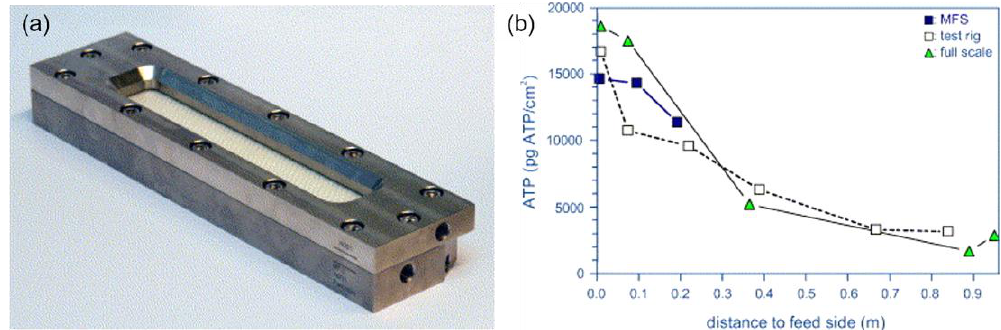
Figure 7. ( a ) A photograph of the developed membrane fouling simulator (MFS), external dimensions of 7 cm × 30 cm × 4 cm); ( b ) Biomass concentration over the length of the MFS in comparison with